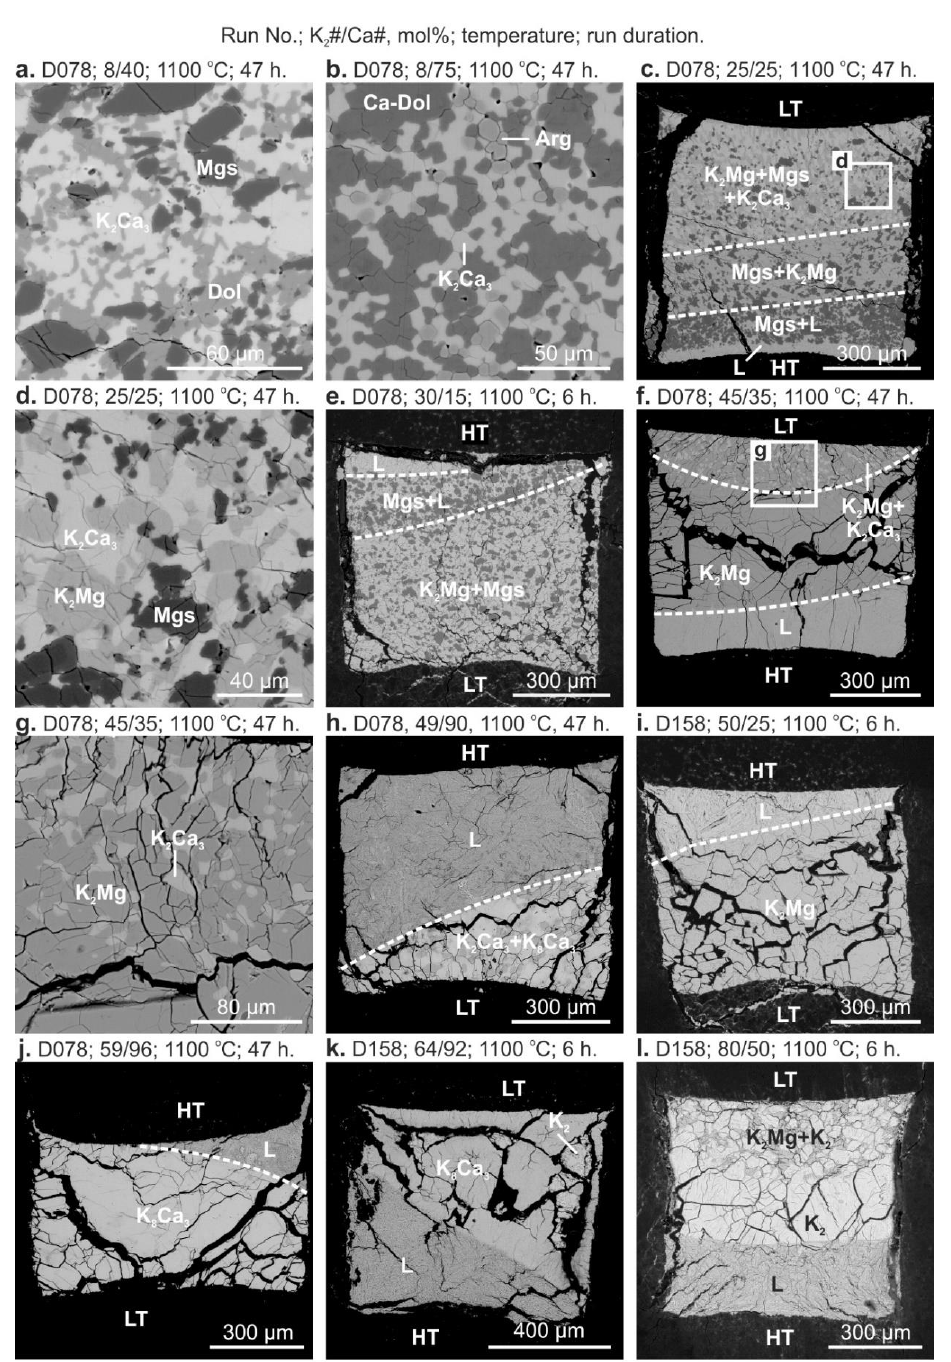
Figure 2. BSE images of sample cross-sections illustrating phase relationships in the system K 2 CO 3 −CaCO 3 – MgCO 3 at 6 GPa and 1100 °C. K 2 #/Ca# indicates bulk composition of the starting mixture, K 2 # = 100 · K 2 CO 3 / (K 2 CO 3 + CaCO 3 + MgCO 3 ), Ca# = 100 · CaCO 3 / (CaCO 3 + MgCO 3 ). LT — low-temperature side. HT — high-temperature side. See the Nomenclature section for abbreviations.